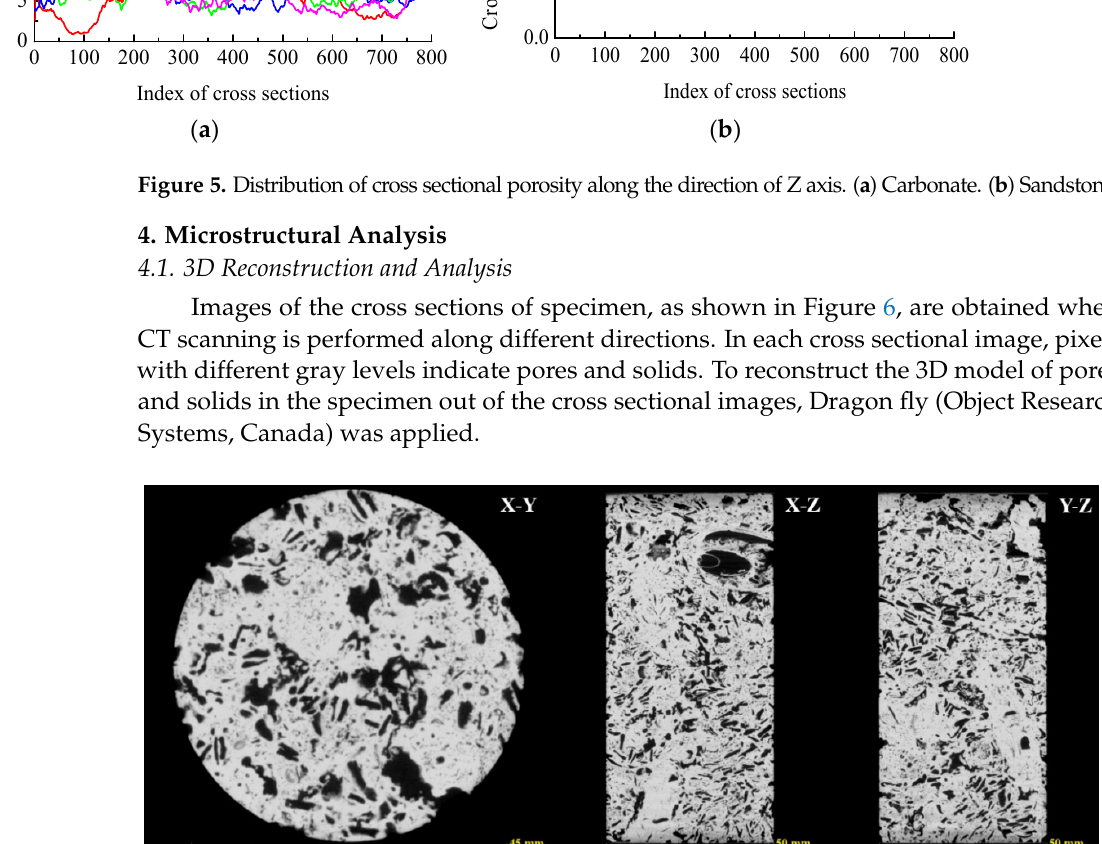
Figure 5. Distribution of cross sectional porosity along the direction of Z axis. ( a ) Carbonate. ( b ) Sandstone.